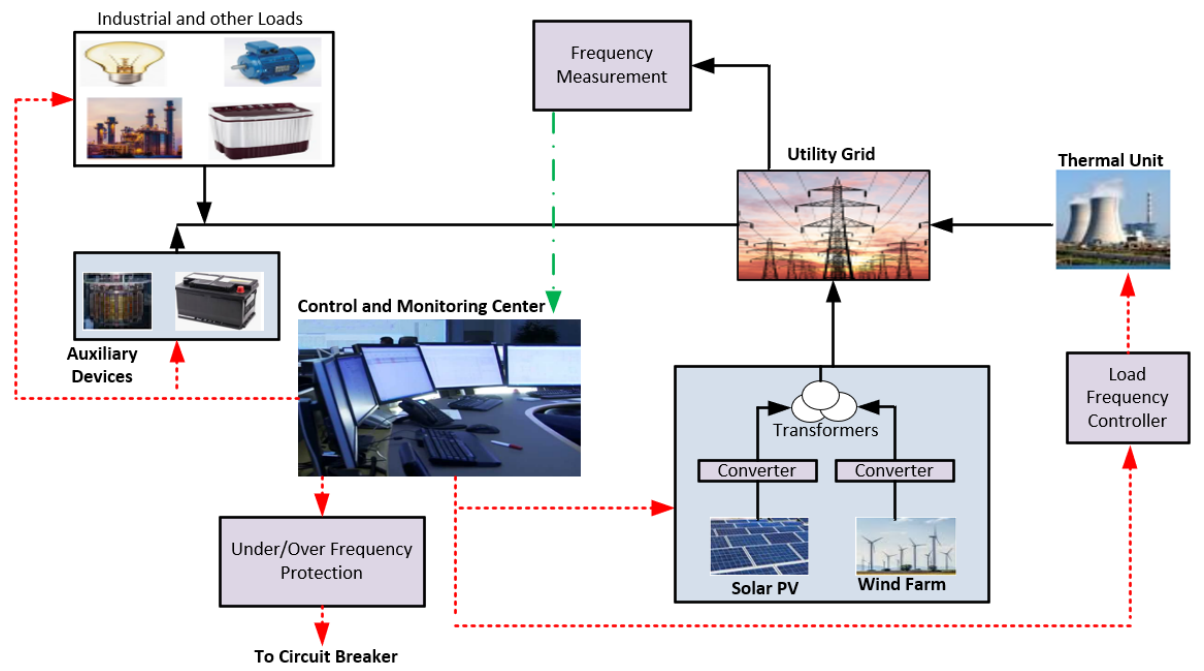
Figure 1. Power system and control block diagram with RESs and